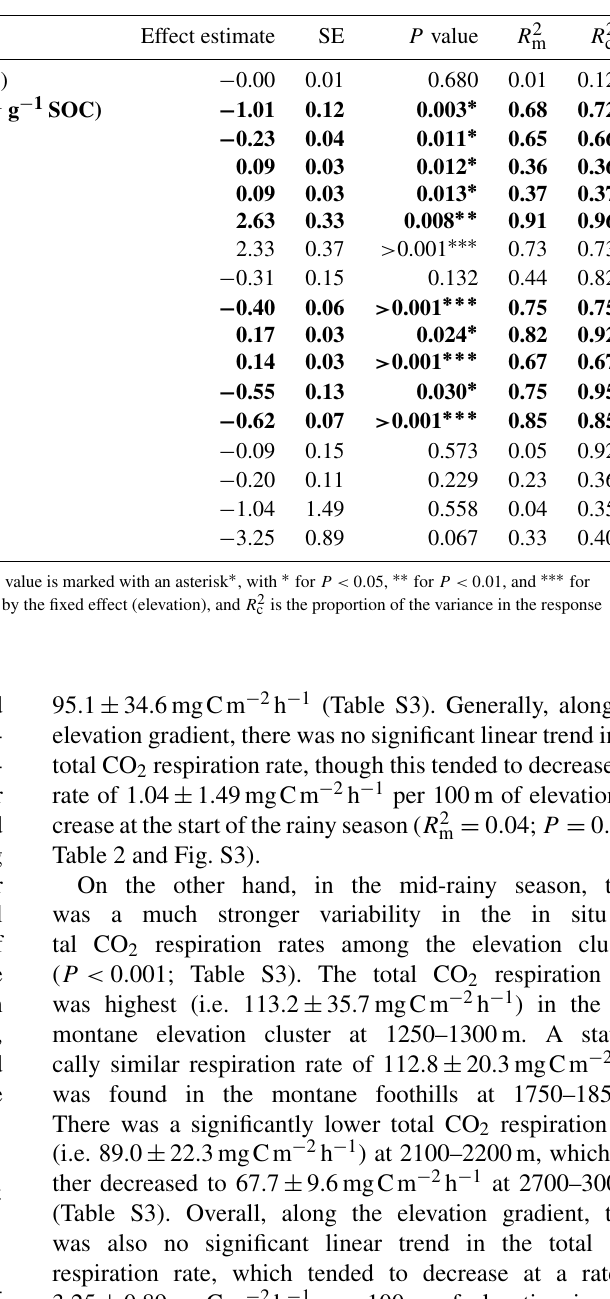
Table 2. Fixed effect estimates of elevation (per 100m elevation increase) on selected soil parameters. The associated standard error (SE), P value, marginal coefficient of determination ( R 2 m ), and conditional coefficient of determination ( R 2 c ) are